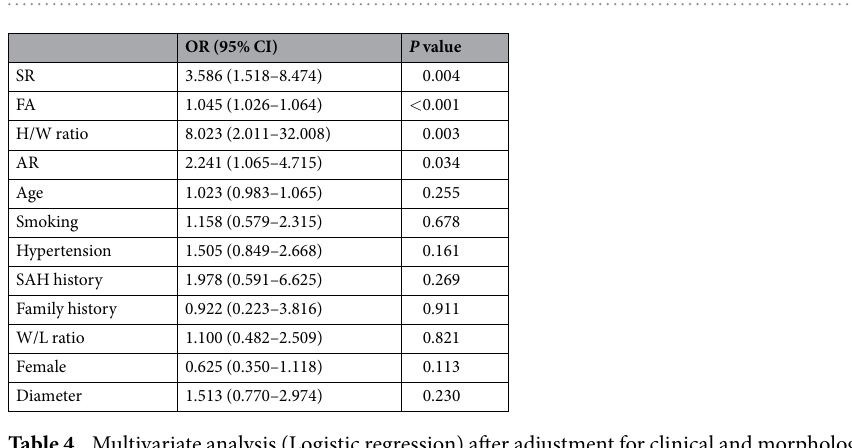
Table 4. Multivariate analysis (Logistic regression) after adjustment for clinical and morphological risk